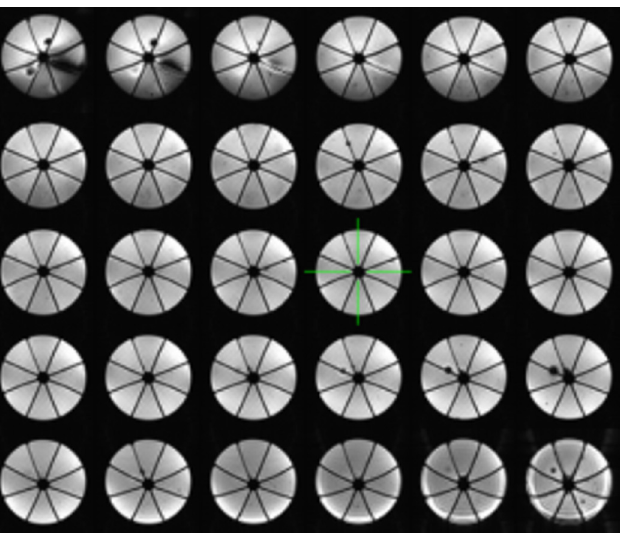
Fig 2. An example of 2D EPI image set obtained using the phantom. TR/TE/FA = 4000ms/30ms/90°, matrix = 64x64, number of slices = 30, voxel size = 3.52mm x 3.52mm, slice thickness = 5 mm. The outer slices show distortion as evidenced by the curved partitions and signal loss due to the drop off in coil sensitivity.